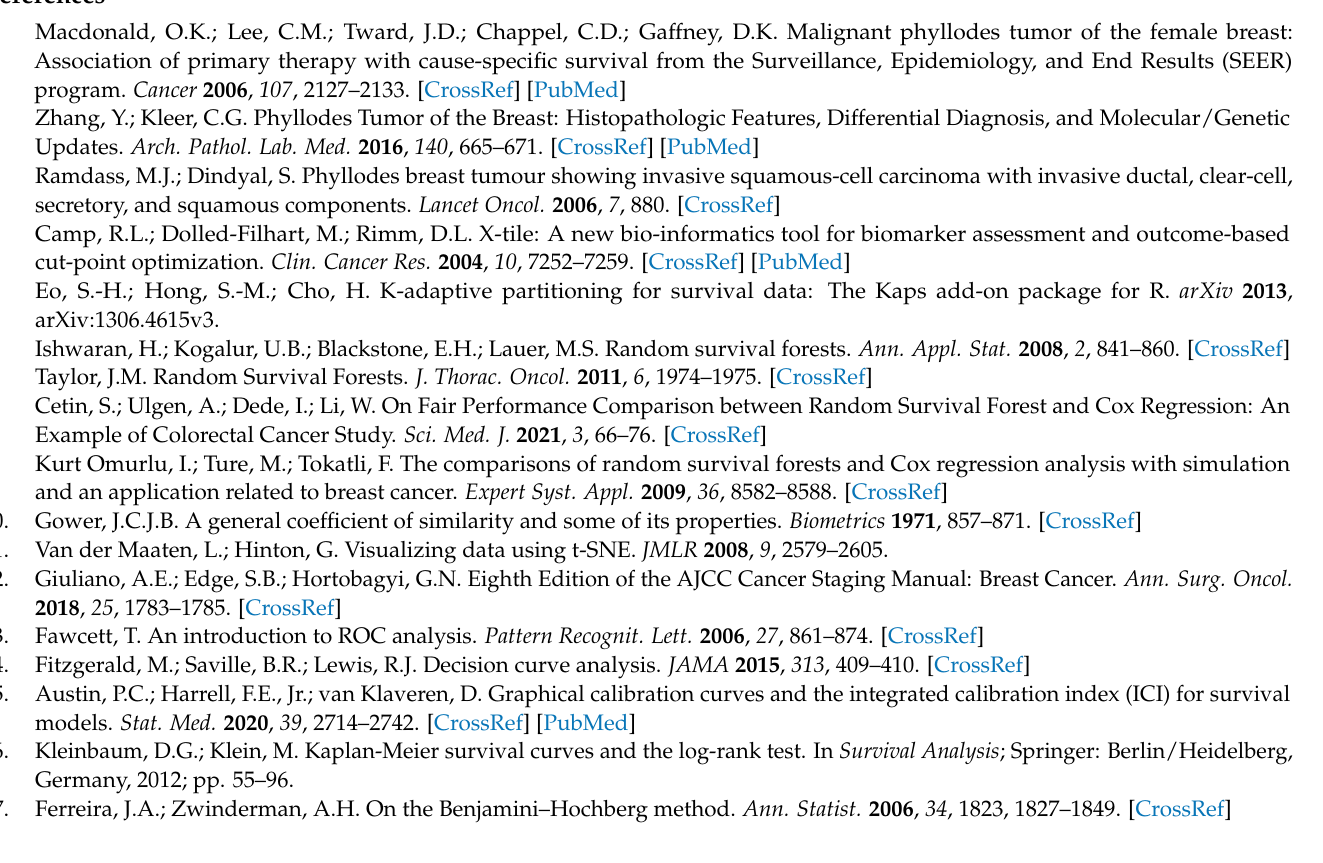
five new T stages in training set and test set. Figure S2: Construction of age groups for MPTB patients. (A) Kaplan–Meier plot showing overall survival stratified by two age groups in training set and test set. (B) Kaplan–Meier plot showing overall survival stratified by three age groups in training set and test set. (C) Kaplan–Meier plot showing overall survival stratified by four age groups in training set and test set. Figure S3. Calculation of variable importance (VIMP) for variables. Table S1: Results of the parameter tuning of